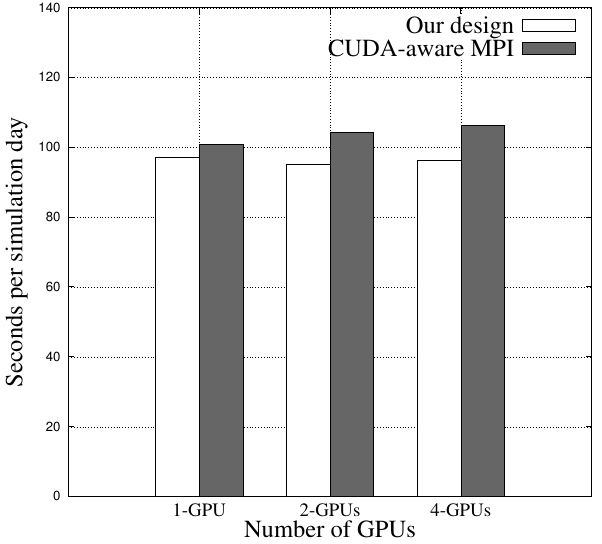
Figure 12. I / O test for the